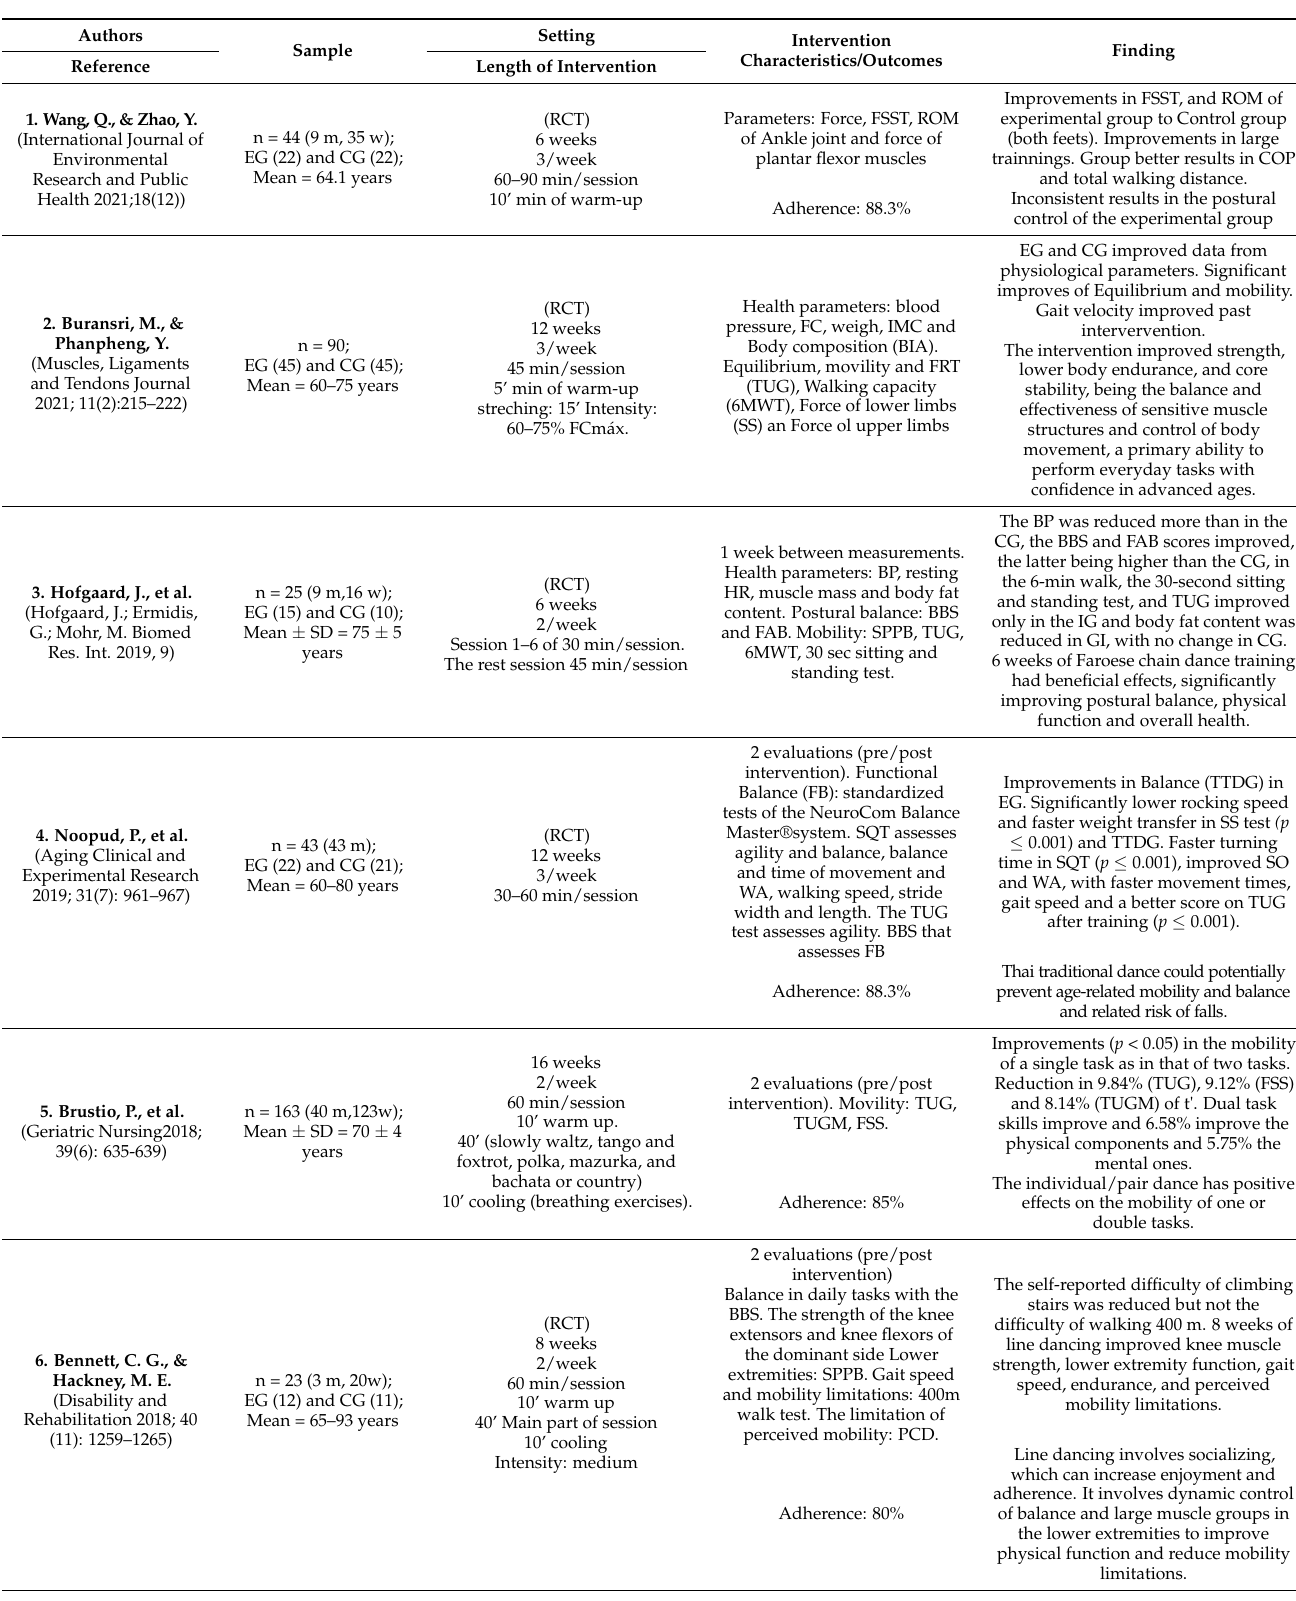
Table 5. Parameters evaluated in the studies considered for